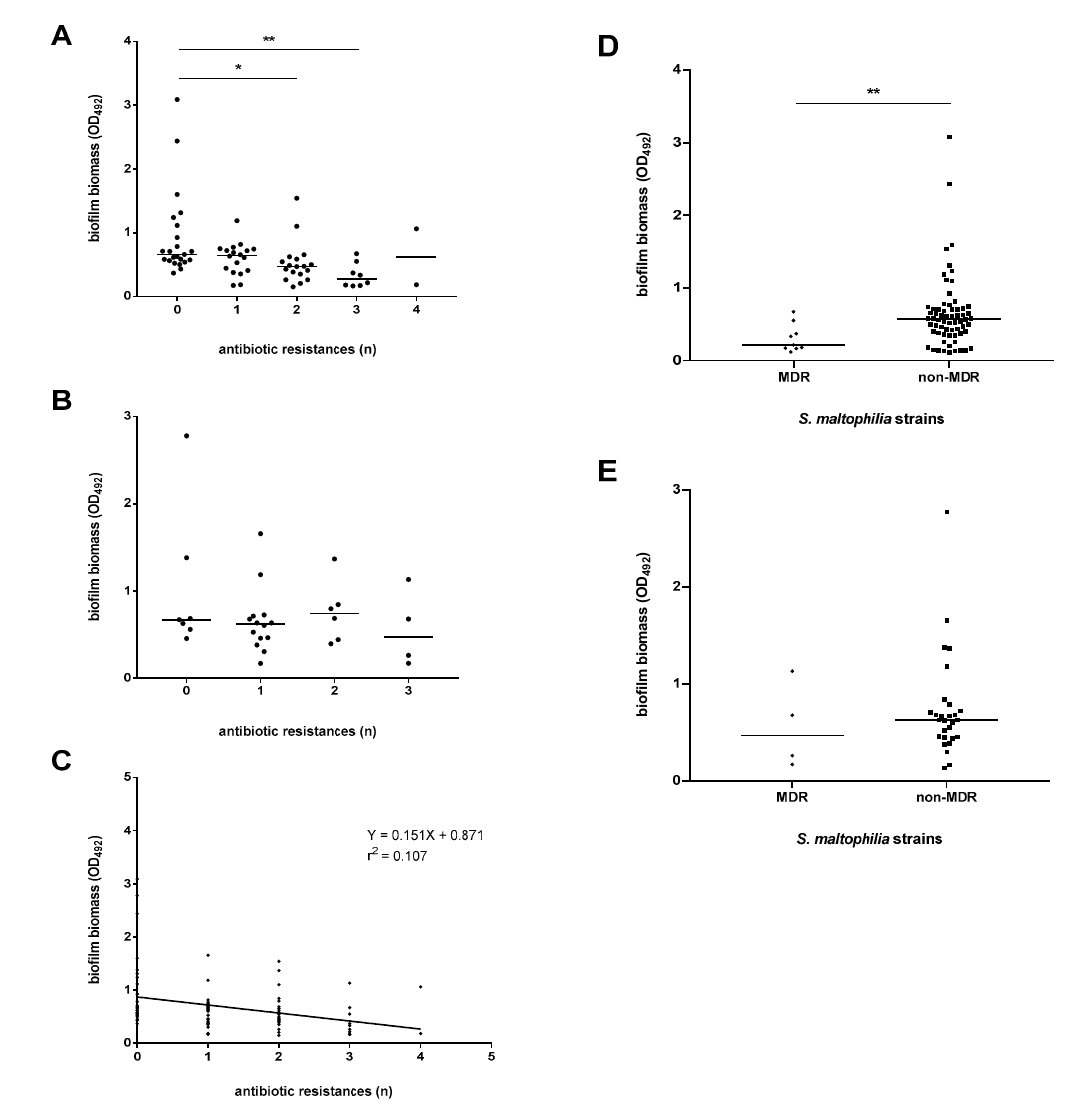
Figure 8. Biofilm formation by S. maltophilia strains: stratification on the number of antibiotic resistances. Biofilm biomass formed after a 24 h-incubation at 37 ◦ C was measured by microtiter plate assay. Results were stratified on the strains’ pathogenic role, assigned according to the CDC guidelines [22]: ( A , D ) pathogen (definite + probable + possible); ( B , E ) non-pathogen. ( C ) Linear regression between biofilm formation and the number of resistances ( r 2 = 0.107; p < 0.001). Each dot shows the mean OD 492 value, with the horizontal line showing the median value of each distribution. * p < 0.05, ** p < 0.01, Kruskal-Wallis test followed by a Dunn’s multiple comparison post-test ( A , B ), or Mann-Whitney test ( D , E ).